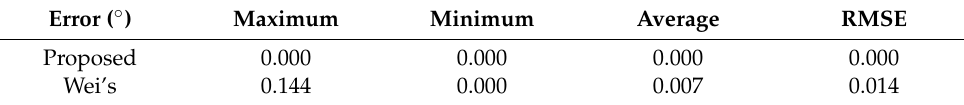
Table 4. The error of the